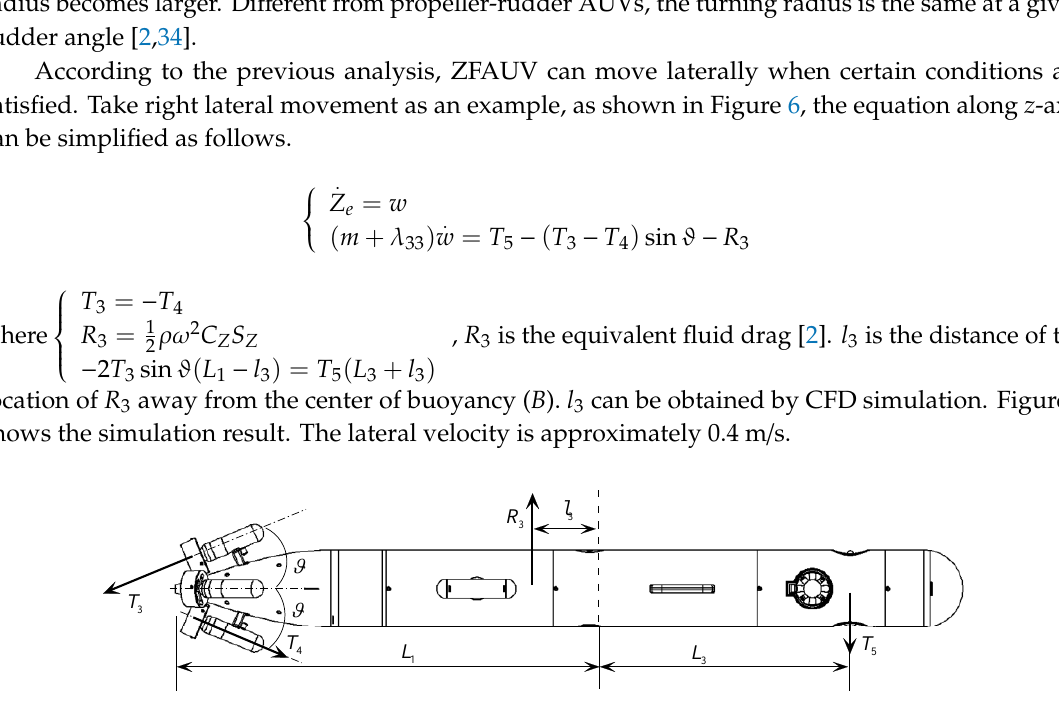
Figure 7. Simulation result of lateral movement.